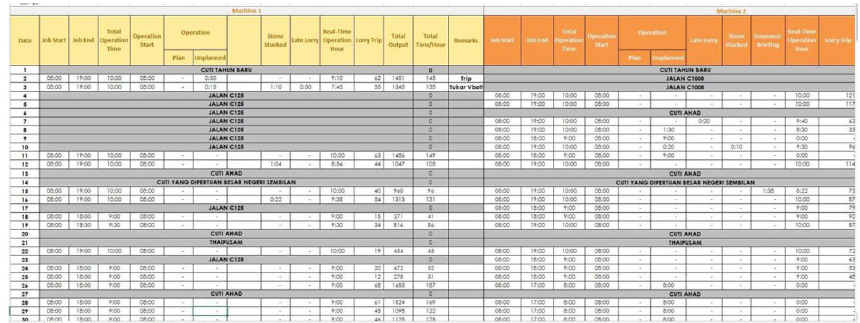
Fig. 2 Preview of the production dataset—the raw